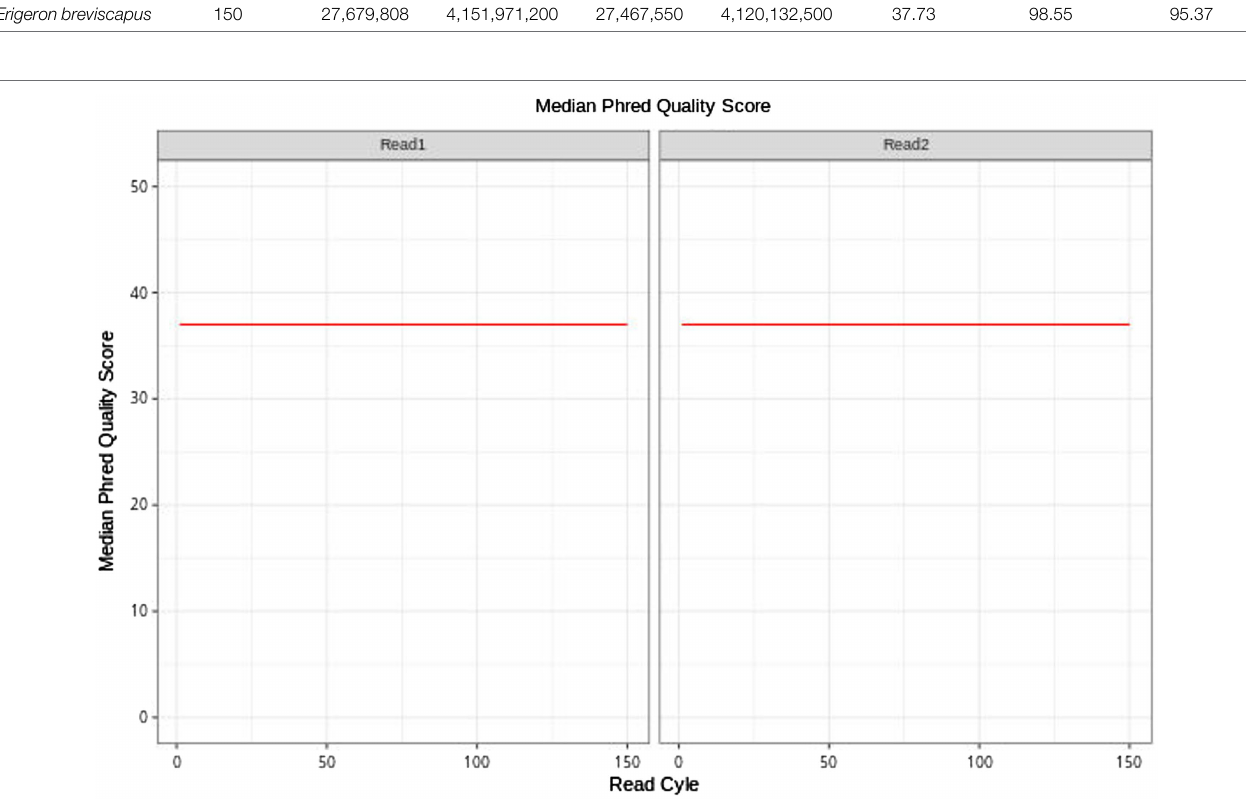
( Figure 2 ; Table 2 ). The GC contents of the LSC, SSC, and IR and whole cp genome were 35.06, 31.00, 43.13, and 37.20%, respectively, which were consistent with the published E.